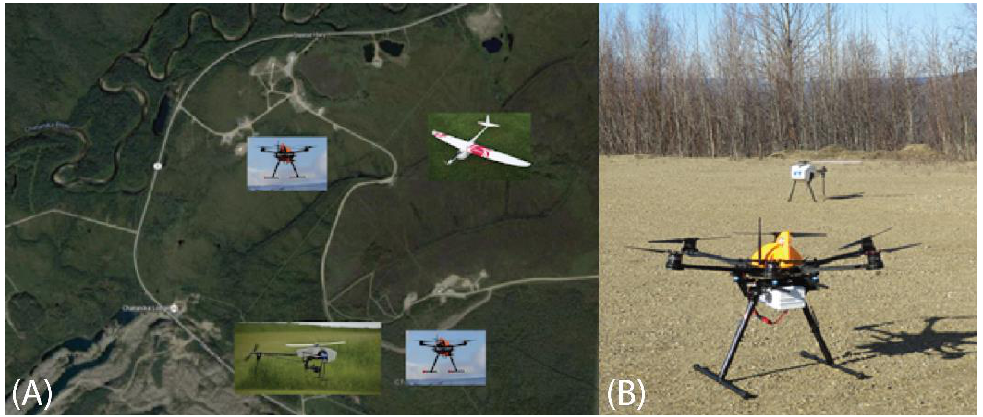
Figure 7. NASA Ames UAS operations for UTM TCL1 [21].